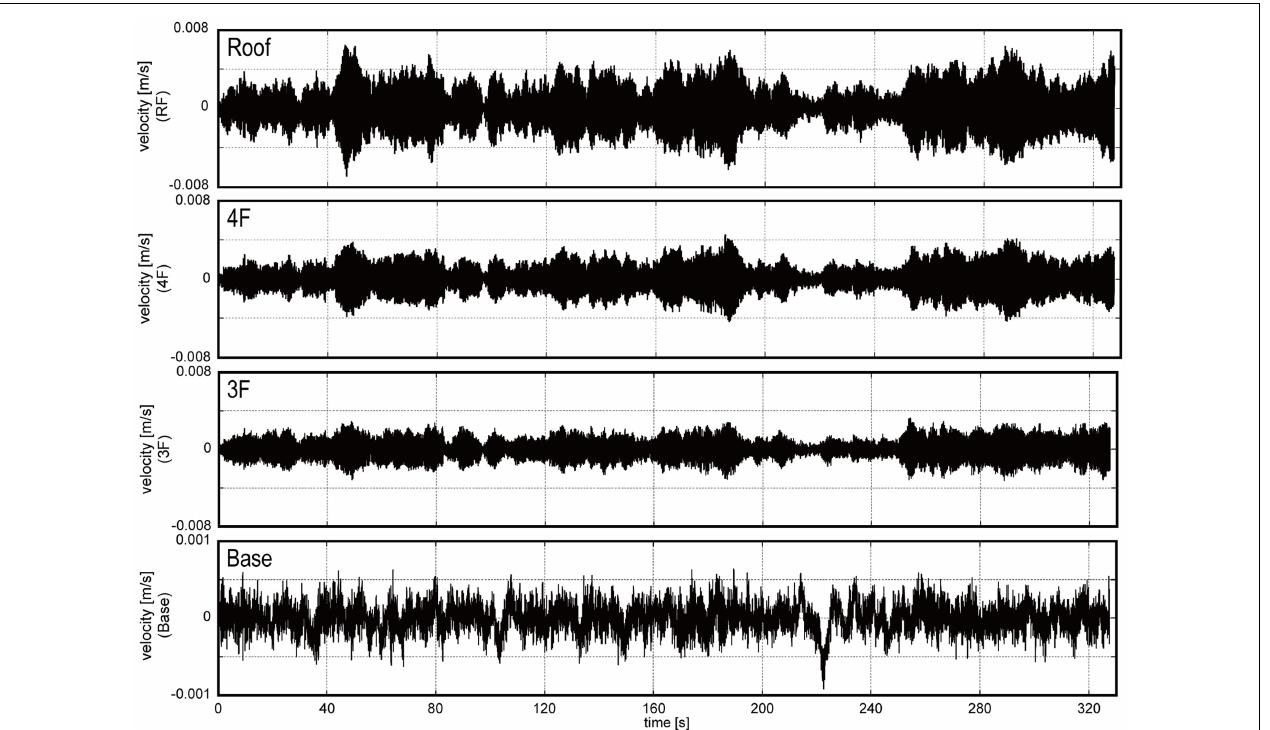
FIGURE 5 | Examples of recorded data (ground level, 3rd floor, 4th floor, and roof)